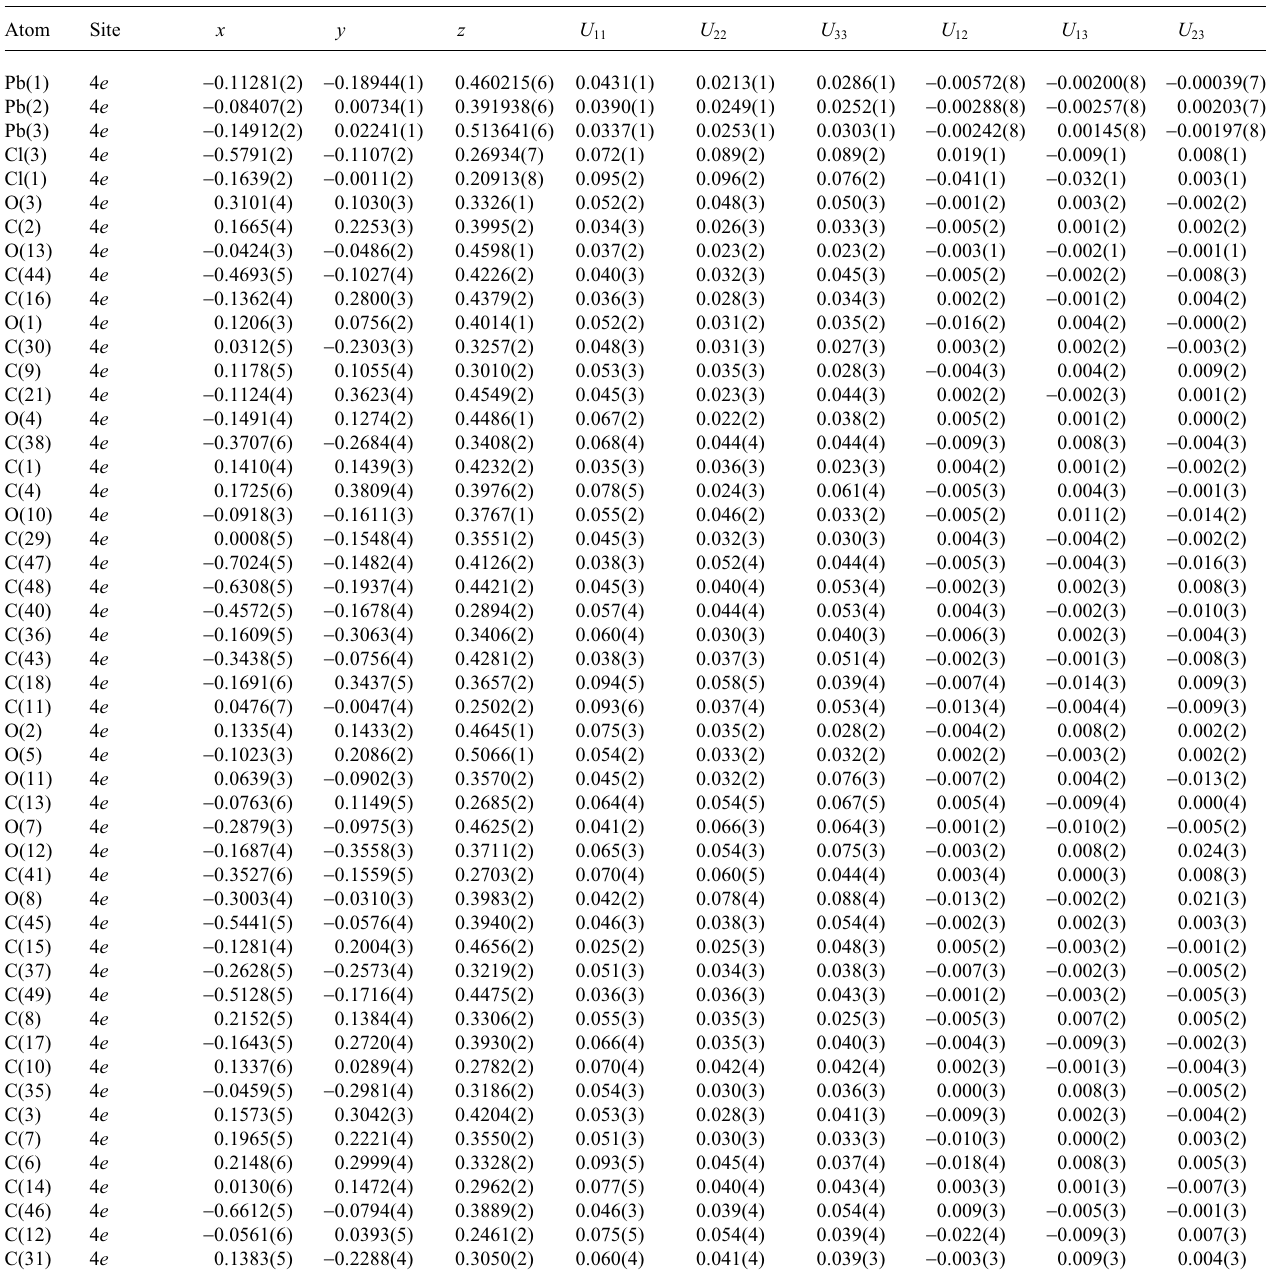
Table 3. Atomic coordinates and displacement parameters (in Å 2